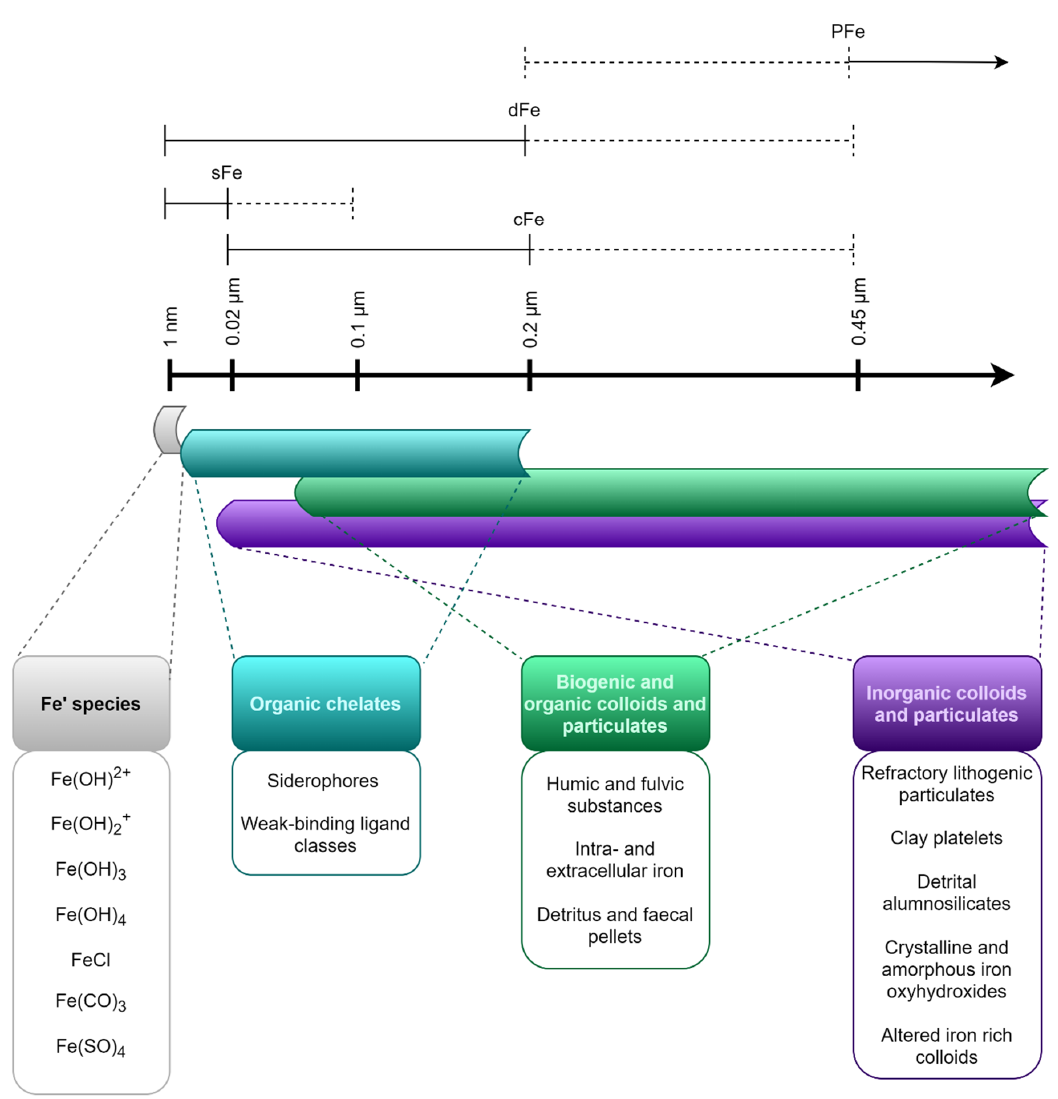
Figure 4. The operationally defined size fractions of iron in the ocean. Sizes of particulate iron (PFe), dissolved iron (dFe), colloidal iron (cFe), and soluble iron (sFe) are indicated in µm. Dotted lines indicate the range of definition. Typical iron-containing substances found within each size spectrum are indicated below. Modified from Bruland and Rue [115] as well as von der Heyden and Roychoudhury [114].